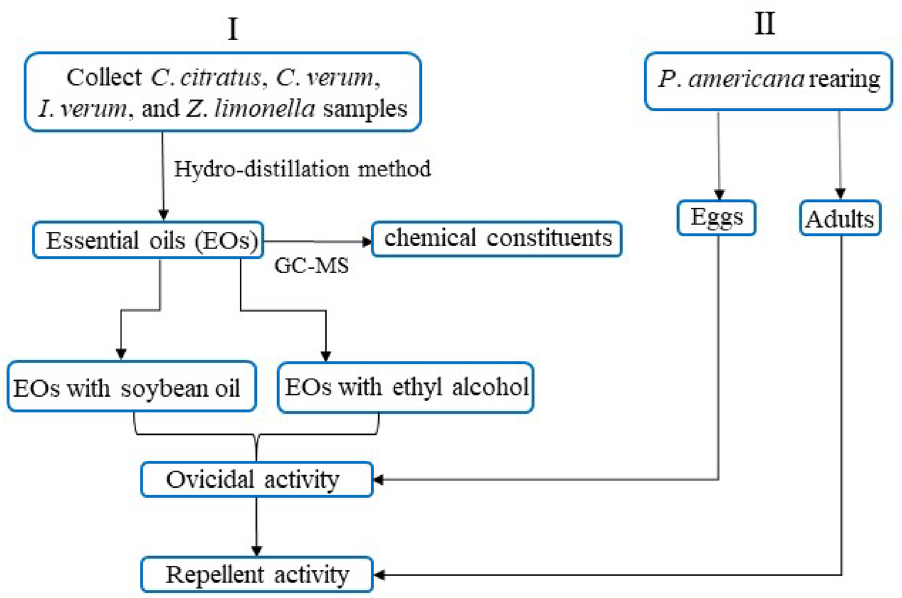
Figure 1. Schematic diagram of the experimental